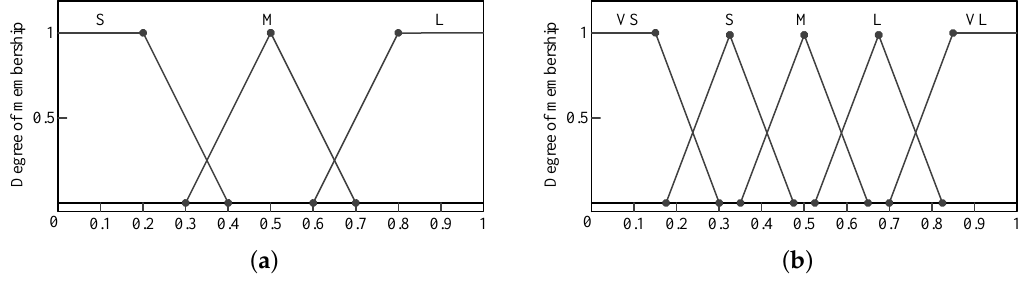
Figure 5. Membership functions. ( a ) Two inputs and ( b ) An